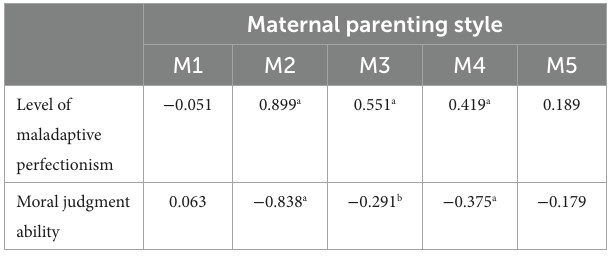
TABLE 3 Correlation between maternal parenting style and perfectionism and moral judgment ability of OCD patients (r value).